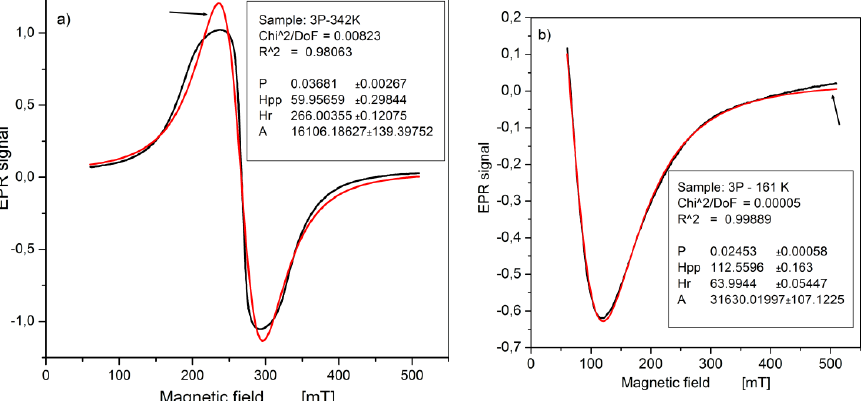
Figure 6. Representative EPR spectra of Cd 1 − x Cr x Te powdered crystals: ( a ) sample No. 3p at T = 342 K, ( b ) sample No 3p at T = 161 K. The arrow marks the theoretical line. The fitting parameters are given in the legend.